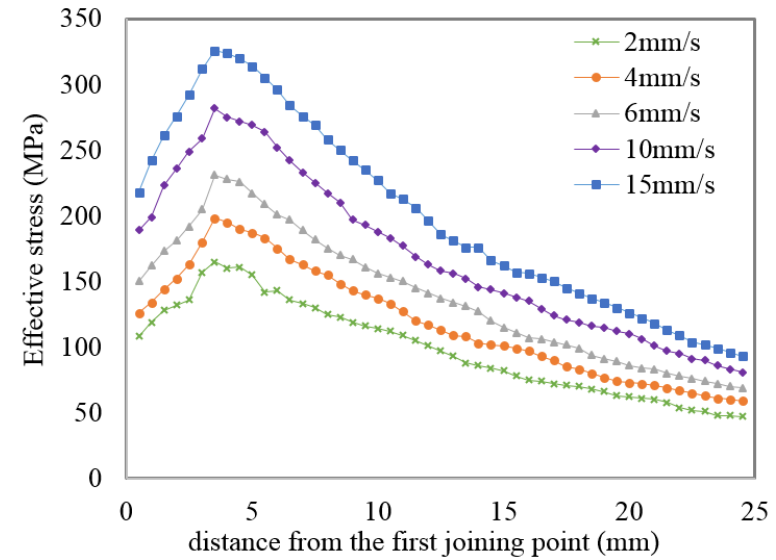
Figure 6. Effective stress within the welding chamber at different ram speeds and at a billet temperature of 470 °C.